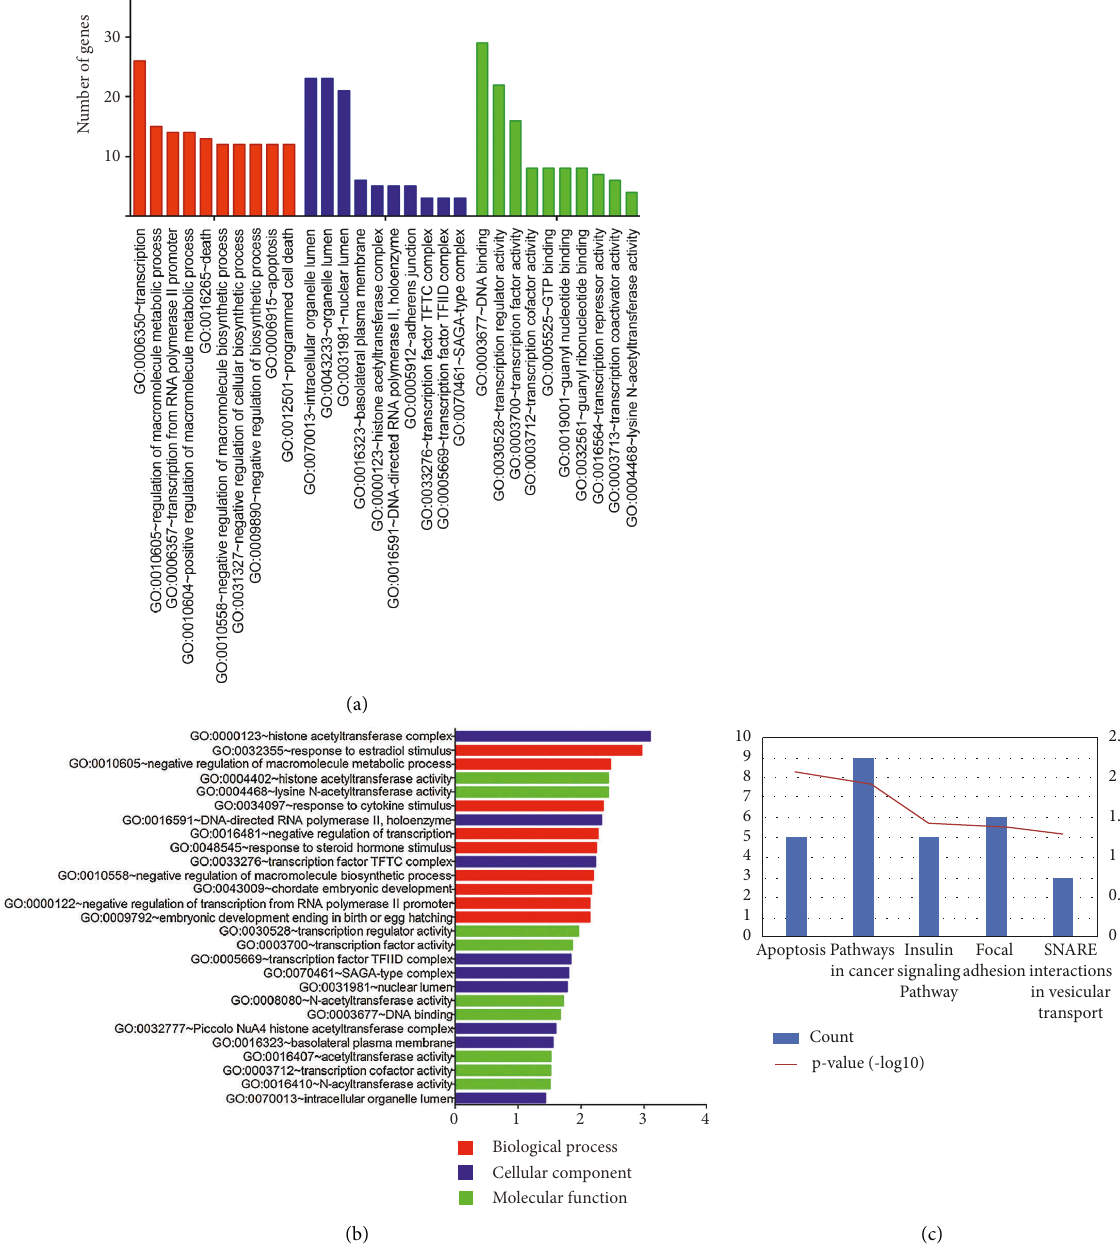
Figure 2: GO and KEGG of DEGs from two microarrays. (a) Sorted by descending order of the number of genes associated with the listed GO ID. (b) Sorted by descending order of − Log10 ( P -value) for the GO enrichment terms. (c) KEGG pathway of DEGs expressed in inflammatory breast cancer using the DAVID